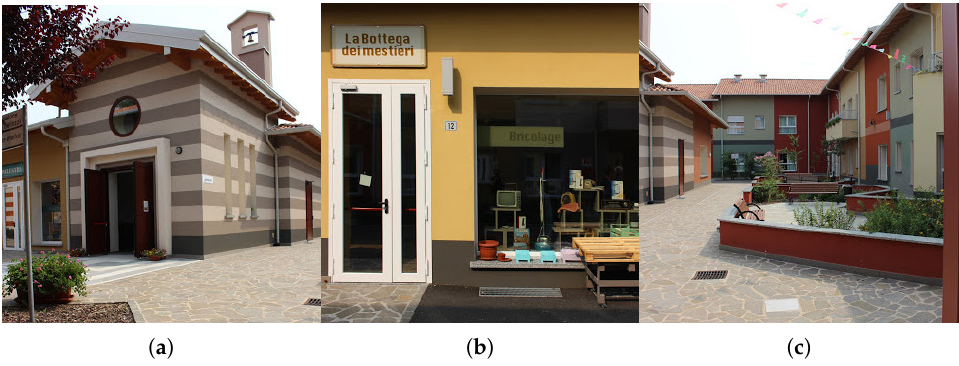
Figure 1. Il Paese Ritrovato . ( a ) Village chapel. ( b ) Bricolage lab. ( c )